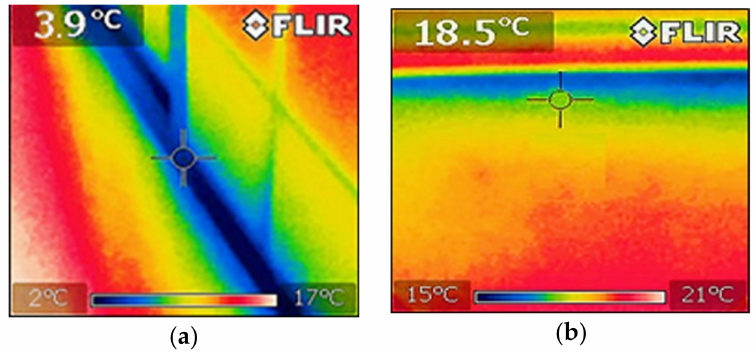
Figure 7. ( a ) Floor temperature before thermal barrier; ( b ) floor temperature after using thermal barrier.